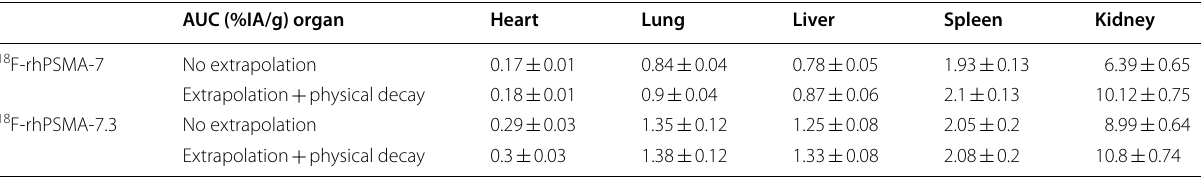
AUC: area under the curve; %IA: %injected activity. AUC is presented